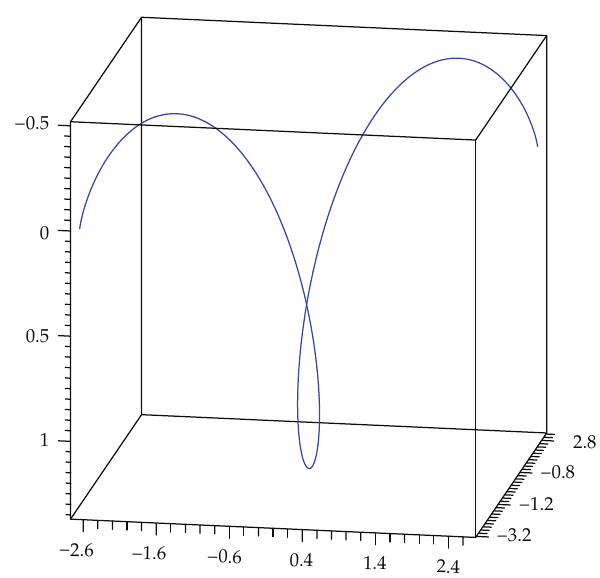
Figure 3: Null Cartan curve γ (cid:3) s (cid:4) .